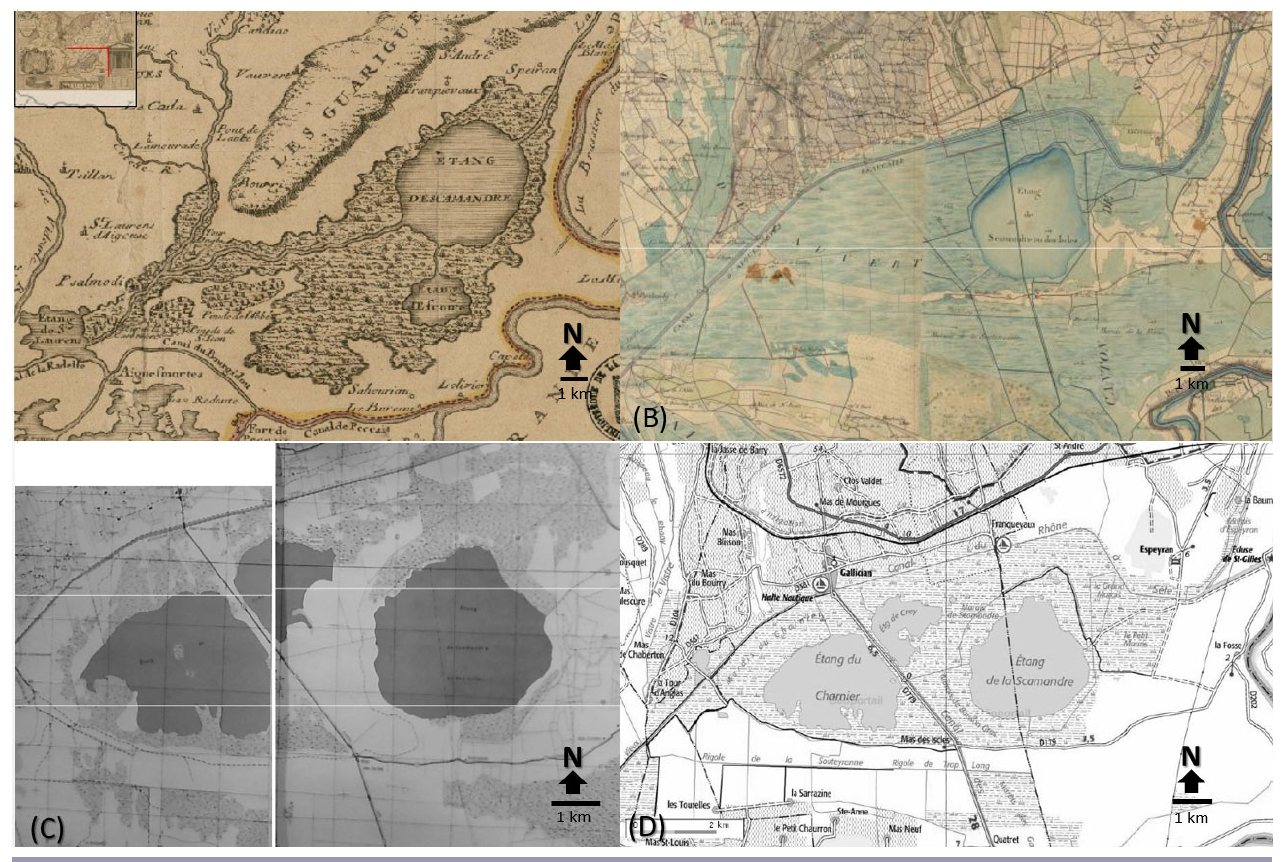
Fig. 3. Four maps of the Scamandre Marshes showing major changes in the landscape, especially the formation of two new large ponds, western part of the Camargue Biosphere Reserve, southern France. (A) Details of 1698 map made by H. Gauthier, Diocèse de Nismes. The small pond below the Scamandre Pond is Escoute Pond, later drained. (B) Details of 1850 map made by E. Dumas, Carte Géologique du Departement du Gard. The tiny remains of Escoute Pond are visible to the south of Scamandre Pond. (C) Details of 1944 map made by the U.S. Army, sheet XXVIII-43/44, southern France, 1/25,000, based on aerial photographs